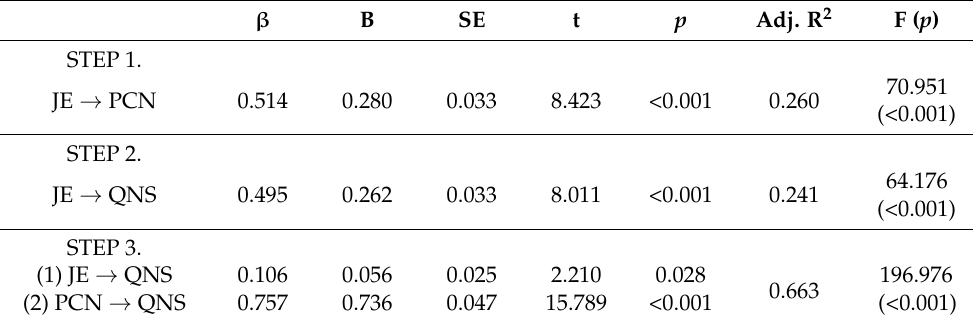
Table 4. Mediating effects of person-centered nursing on the relationship between job engagement and quality of nursing services ( N = 200).